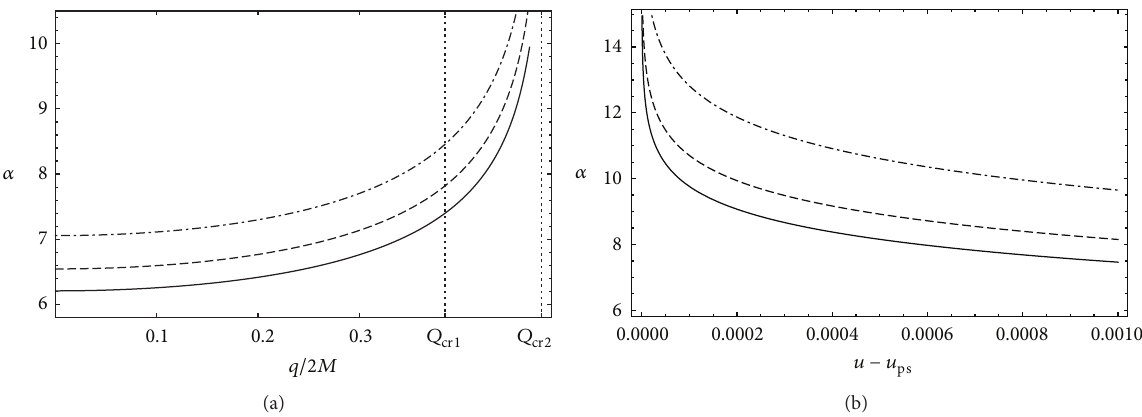
Figure 4: (a) The deflection angle 𝛼 as a function of 𝑞/2𝑀 with 𝑢 = 𝑢 (b) The deflection angle 𝛼 as a function of (𝑢 − 𝑢